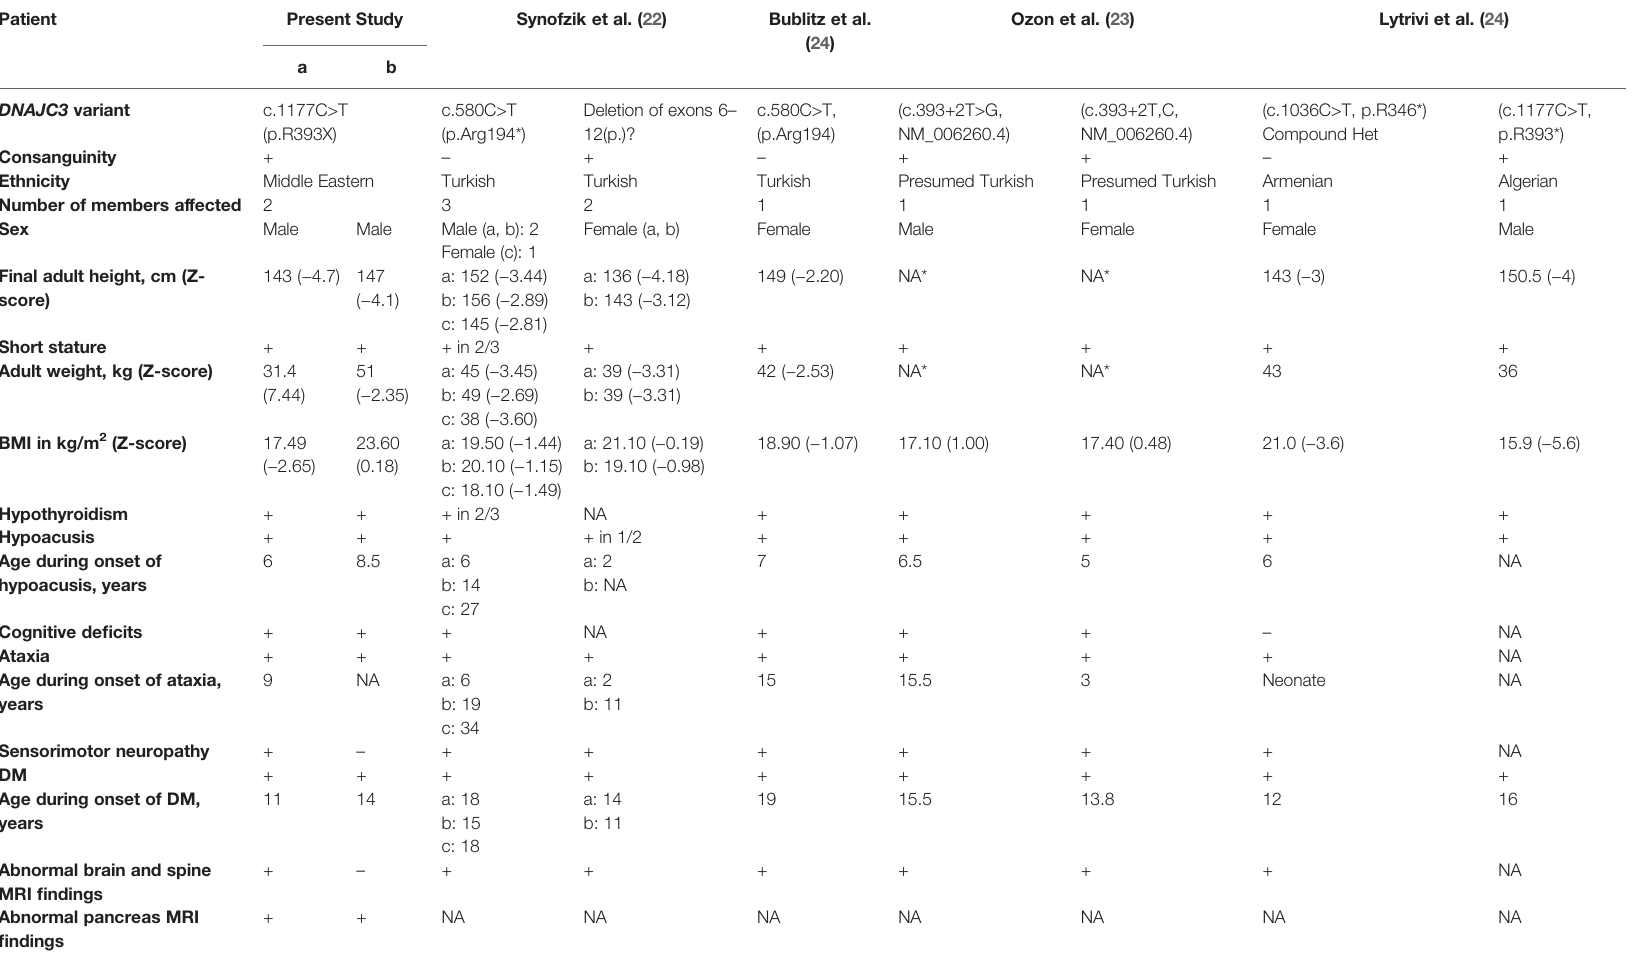
*Final adult height and weight was not achieved at date of publication. BMI, body mass index; DM, diabetes mellitus; NA, not available Z-scores and SDS are based on Centers for Disease Control and Prevention growth charts 2000